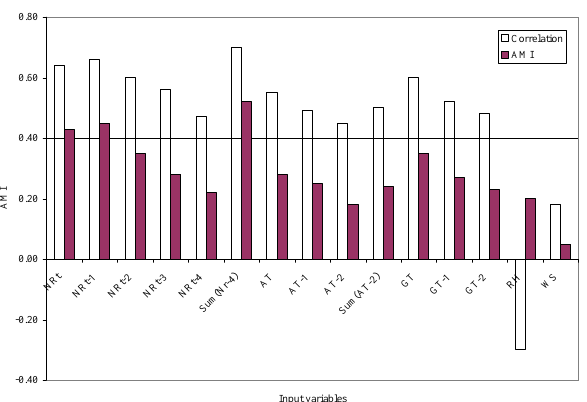
Fig. 4. Statistical properties of the training/cross-validation/testing subsets for 100 random realizations. T r : Training; V a : Validation; T e :